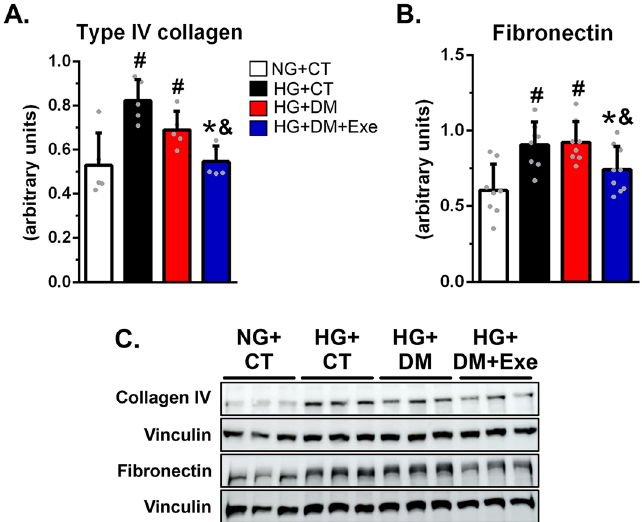
Figure 5. Sera from diabetic exercised individuals and not from sedentary diabetics prevented extracellular matrix accumulation in HK-2 cells exposed to high glucose. ( A – C ) Western blot analysis of type IV collagen, fibronectin, and vinculin ( C ) in HK-2 cells, followed by quantitation of collagen IV/vinculin ( A ), and fibronectin/vinculin ( B ). Protein expression levels were normalized to vinculin. Blots are representative of three independent experiments. Results are means ± SE. NG + CT, normal glucose (5.6 mmol/L) plus 4% of serum from non-diabetic patients; HG + CT, high glucose (30 mmol/L glucose) plus 4% of serum from non-diabetic patients; HG + DM, high glucose (30 mmol/L glucose) plus 4% of serum from sedentary diabetic patients; HG + DM + Exe, high glucose (30 mmol/L glucose) plus 4% of serum from diabetic patients submitted to exercise training. # p < 0.05 vs NG + CT, * p < 0.05 vs HG + CT, and & p < 0.05 vs HG +